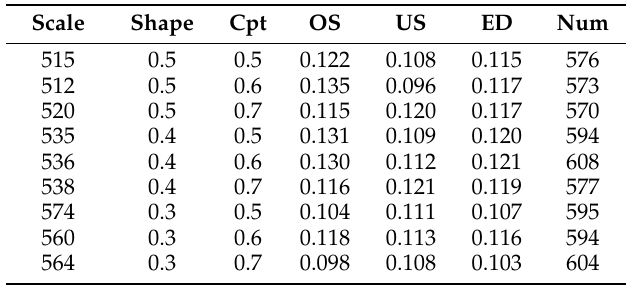
Table 4. Segmentation accuracy metrics for Changwu based on DOM strategy. (Cpt: compactness, OS: over segementation, US: under segmentation, ED: Euclidian